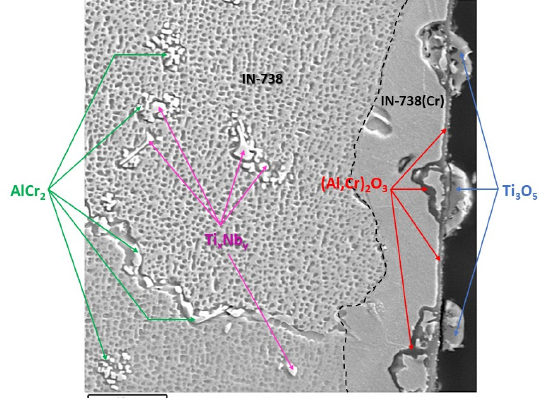
Figure 8. XRD pattern of IN738 100R after He exposure.